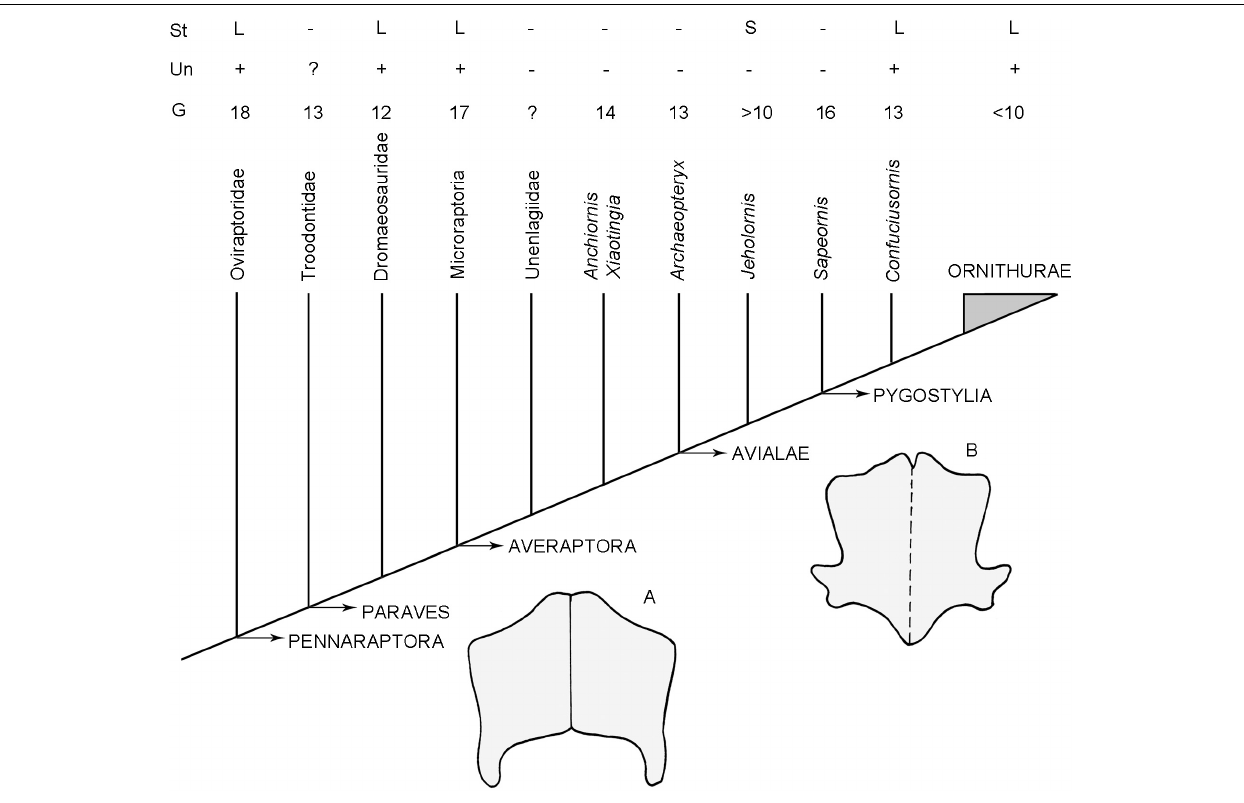
FIGURE 9 | Simplified cladogram showing the phylogenetic relationships of derived coelurosaurs following the proposal of Agnolin and Novas (2013). The figure indicates the number of gastral pairs (G), presence or absence of uncinate process (Un) and relative development of the sternum (St) in avian-line theropods. (A,B) Gross morphology of the sternum of: (A) the dromaeosaurid Linheraptor exquisitus , (B) the pygostylian Eoconfuciusornis zhengi (modified from Zheng et al., 2012). G, number of pairs of gastralia, L, present and large, S, present but small; St, Sternum; Un, Uncinate process; ?, uncertain condition; +, presence; –,